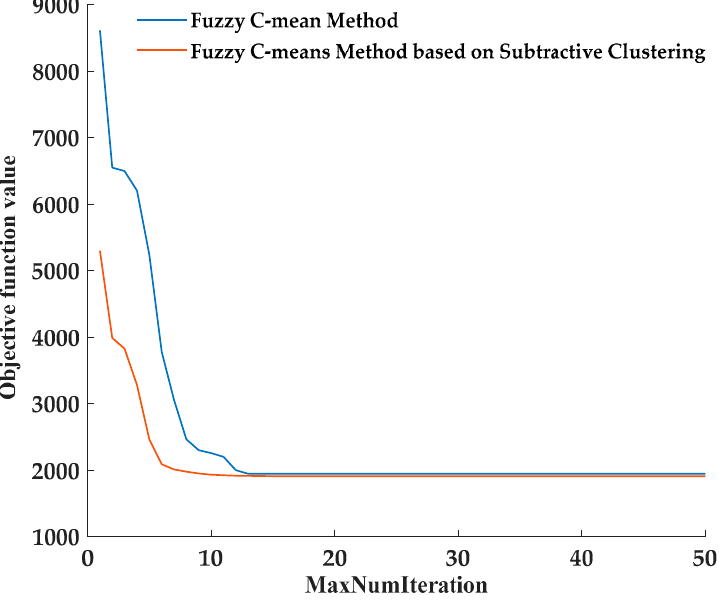
Figure 8. Comparison of the objective function changes.